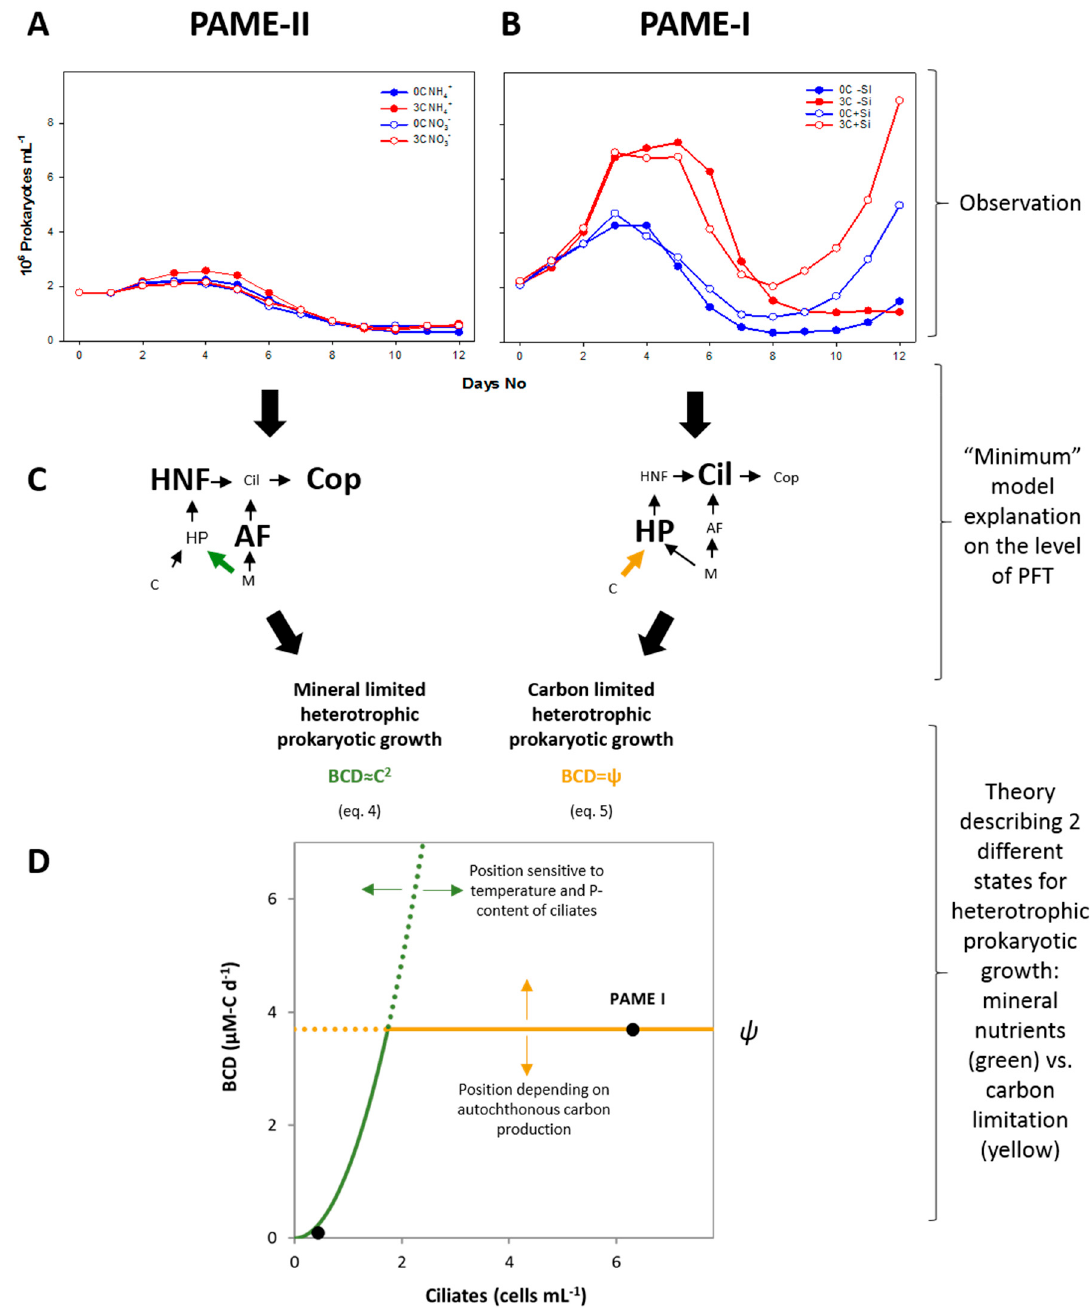
Figure 1. Different heterotrophic prokaryote (HP) responses to glucose additions (( A , B ) data from [8],) are predicted qualitatively by the model ( C ) that links the type of growth rate limitation of bacteria to ciliate abundance ( D ) [8]. ( A ) Observed response in PAME-II was negligible, while ( B ) observed response in PAME I was a strong effect of glucose addition. ( C ) The pentagon food web structure (see also Figure S1, left) has two possible limiting states for heterotrophic prokaryotic growth: ( D ) either free mineral nutrients limitation (MNL), where bacterial carbon demand increases as the square of ciliate biomass increases (green curve); or organic carbon limitation (OCL), where bacterial carbon demand is equal to the supply ( ψ ) of degradable organic-C (yellow line). Since bacterial carbon demand (BCD) cannot sustainably exceed the supply, the shift between the two states occurs at the ciliate density where the green and yellow curves cross. HNF: heterotrophic nanoflagellates; AF: autothrophic flagellates; Cop: copepodes.